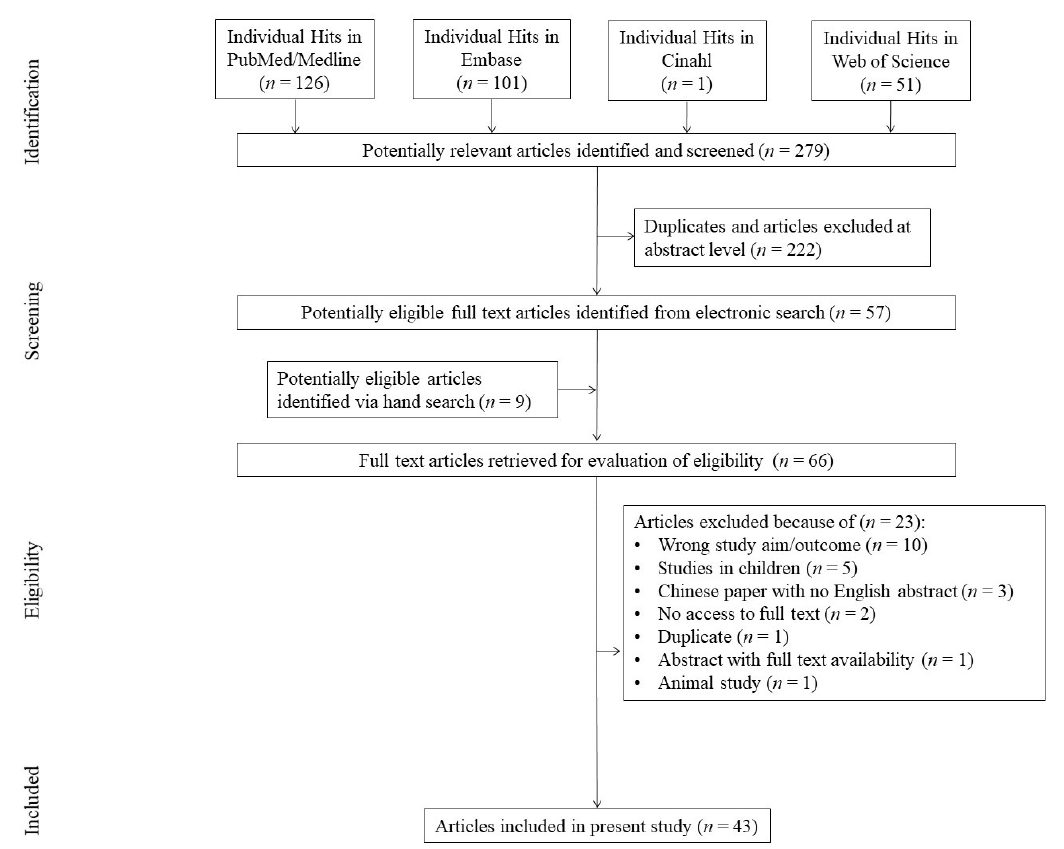
Figure 1. Study and sample characteristics.